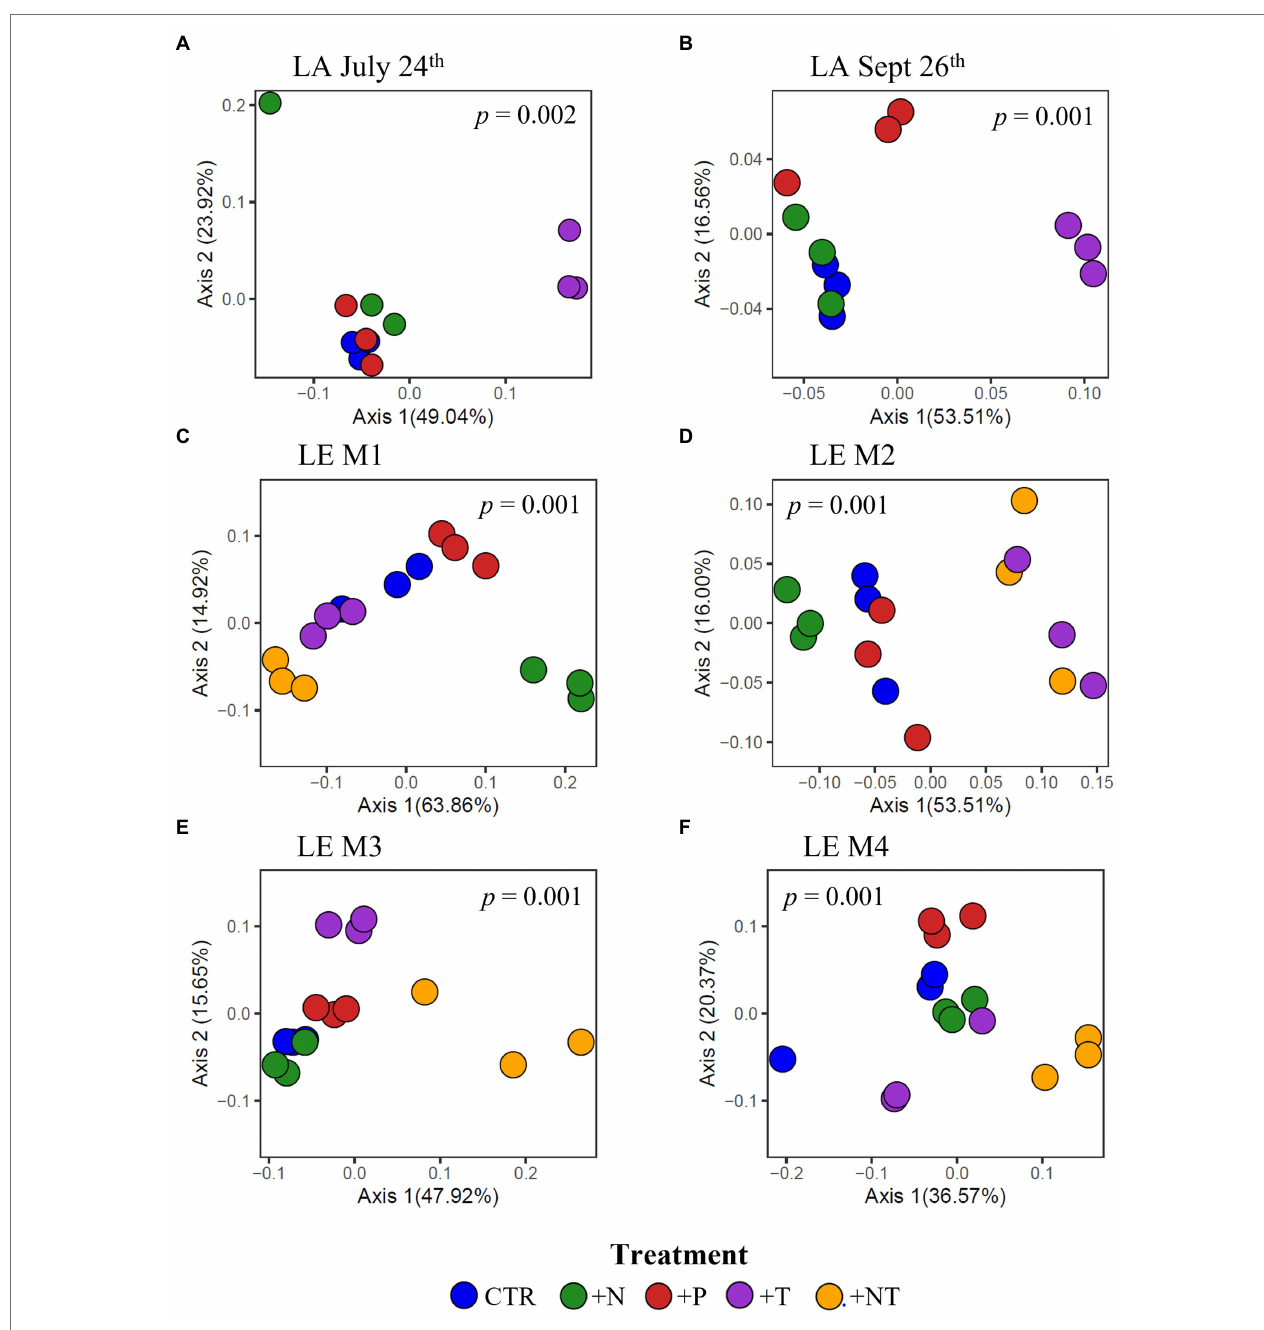
FIGURE 7 | Principal coordinates analysis (PCoA) conducted on ASV abundances showing the dissimilarity of heterotrophic bacteria compositions between samples in the (A) LA July 24th, (B) LA September 26th, (C) LE M1, (D) LE M2, (E) LE M3 and (F) LE M4 experiments. Color denotes the sample treatment (CTR, Control; +N, Nitrate addition; +P, Orthophosphate addition; +T, elevated incubation temperature). Precents listed on the axes represents the percent of variation explained by PC1 and PC2. Value of p indicates the significance of the main effect of treatment on the communities determined via